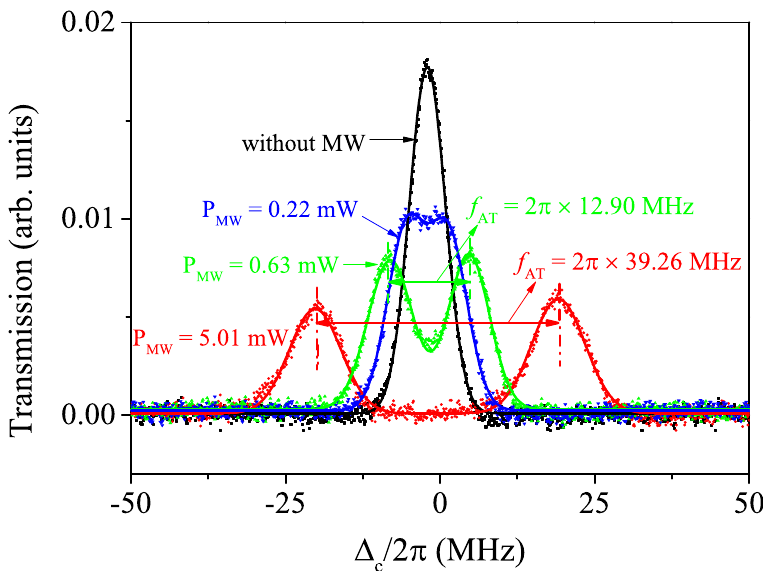
Figure 2. (color online) Measurements of Rydberg EIT-AT spectra as a function of the coupling laser detuning ∆ c with the probe/coupling Rabi frequency Ω p = 2 π × 4.00 MHz and Ω c = 2 π × 4.11 MHz and the indicated microwave power P = 0.22 mW (blue), 0.63 mW (green) and 5.01 mW (red). The frequency of microwave field is set to 15.21 GHz coupling Rydberg transition | 66 S 1/2 (cid:105) → | 65 P 1/2 (cid:105) . The microwave induced AT splitting, f AT , is extracted with the multipeak Lorentz fittings to the EIT-AT spectra (solid lines). The microwave-free EIT signal (black) is obtained with 6 S 1/2 -6P S 3/2 -66 S 1/2 three-level scheme, corresponding EIT linewidth γ EIT = 2 π × (5.83 ± 0.2) MHz.